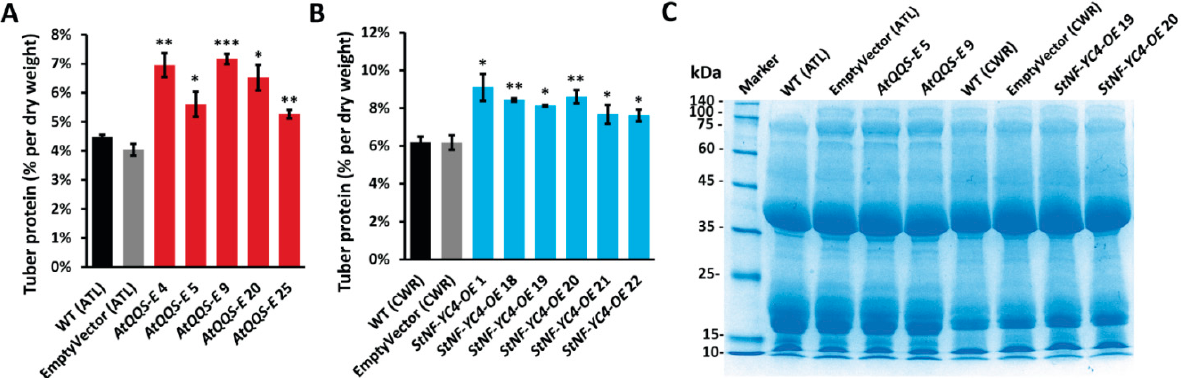
Figure 4. The total protein was uniformly increased in AtQQS-E and StNF-YC4-OE potato tubers. Modified Lowry protein assay was used to quantify total protein content in AtQQS-E ( A ) and StNF- YC4-OE ( B ) potato tubers. All data in bar charts ( A , B ) show mean ± SE, n ≥ 4. Student’s t -test was used to compare protein contents of AtQQS-E , StNF-YC4-OE , and corresponding WT in ( A , B ), *** p < 0.001; ** p < 0.01; * p < 0.05. ( C ) SDS-PAGE analysis of total protein in AtQQS-E and StNF-YC4-OE potato tubers. An equal amount of total protein extracted from potato tubers was used for each SDS- PAGE sample in ( C ). All tubers expressing AtQQS , WT (ATL), and EmptyVector (ATL) are of the ATL variety, and tubers overexpressing StNF-YC4 , WT (CWR), and EmptyVector (CWR) are of the CWR variety.